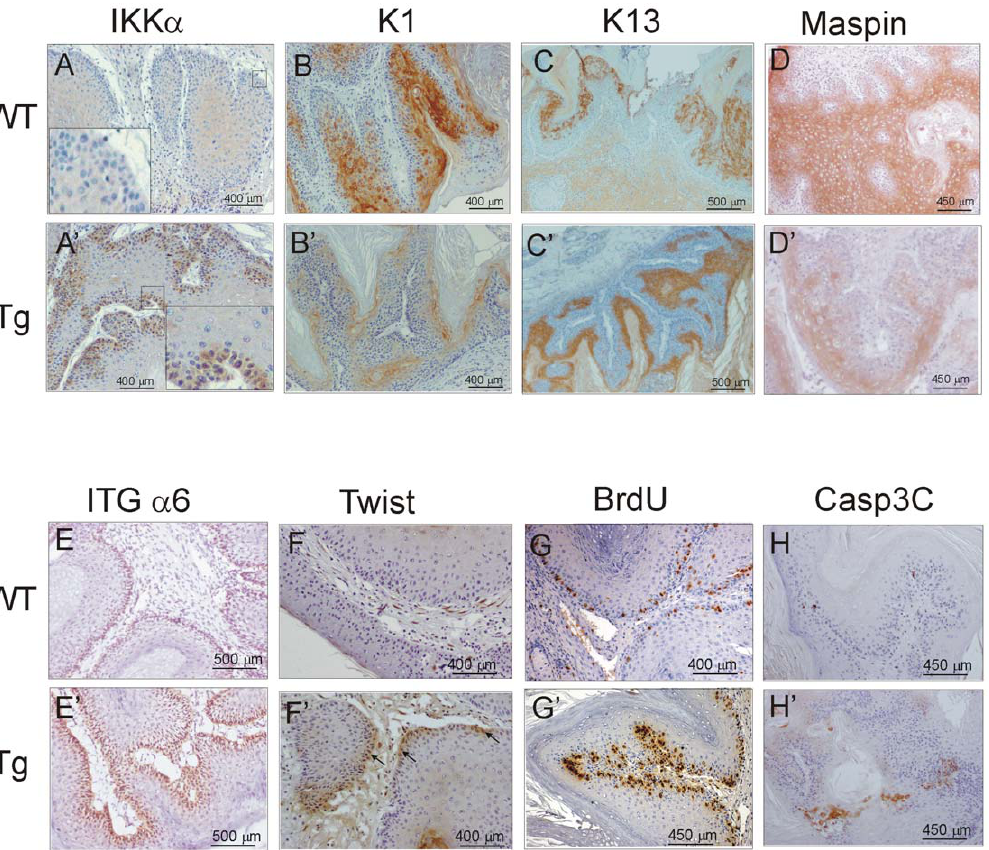
Figure 5. Immunohistochemical analysis of tumor markers in WT and K5-IKK a DMBA/TPA tumors. ( A, A ’) IKK a is scarcely and diffusely expressed in the suprabasal cells of WT tumors while it is strongly expressed in K5-IKK a tumors, mainly in the basal cells, although it is also detected in the suprabasal cells. ( B, B ’) Elevated expression of K1 is detected in WT tumors while Tg tumors exhibit scarce K1 staining. ( C, C ’) K13 immunostaining shows that it is weakly expressed in WT tumors versus the strong expression detected in Tg tumors. ( D, D ’) Lower staining of Maspin in K5-IKK a tumors. ( E, E ’) Strong and delocalized integrin a 6 staining is detected in K5-IKK a tumors while WT tumors show integrin a 6 basal expression. ( F, F ’) Twist is expressed in Tg tumors while it is not detected in WT tumors. ( G, G ’) Higher proliferation rate (measured as BrdU incorporation) is detected in Tg tumors (both in the basal and suprabasal layers) compared to the lower proliferating cells found in the basal layer of WT tumors. ( H, H ’) Increased Caspase 3 cleaved (Casp3C) staining in K5-IKK a tumors compared to that in WT